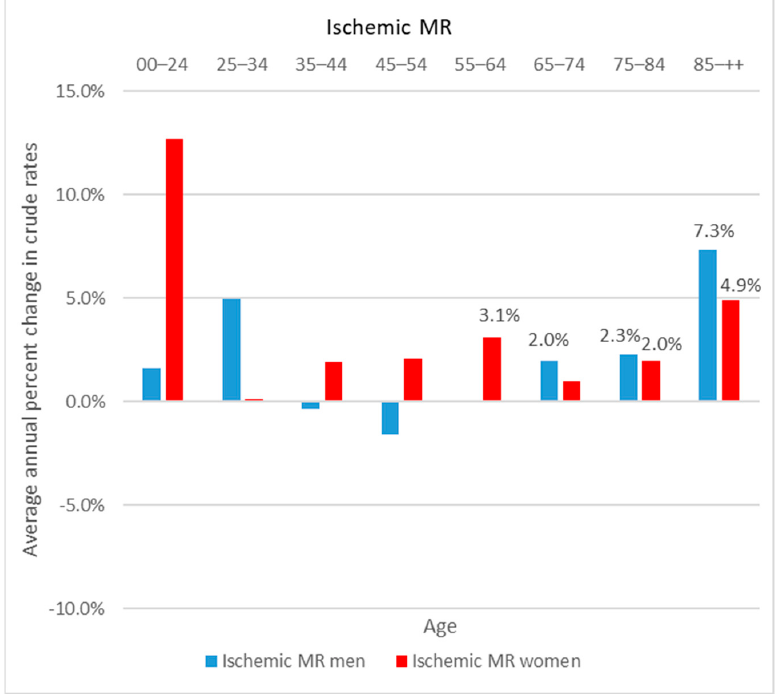
Figure 4. Average annual percent change in crude rates of patients hospitalized for ischemic mitral regurgitation, according to sex, France, 2006–2019. Only values significantly different from 0% are presented (alpha risk = 5%).